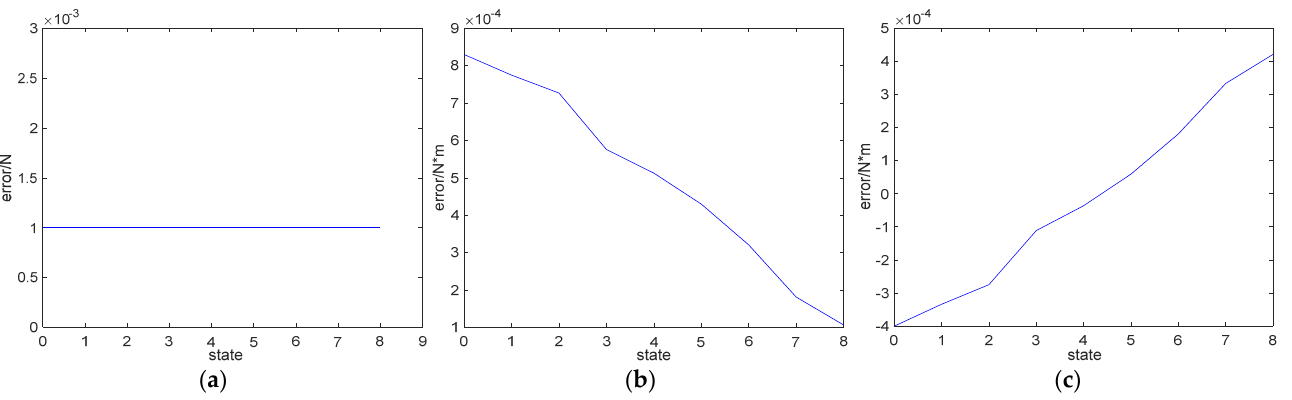
Figure 12. Error of simulation 1. ( a ) Upper kinematic chain. ( b ) Bottom kinematic chain 1. ( c ) Bottom kinematic chain 2.